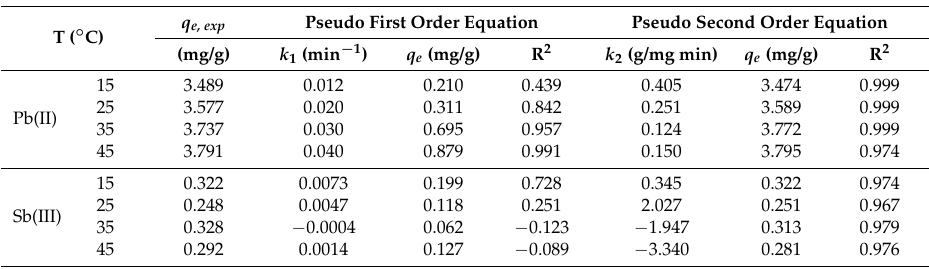
Table 3. Kinetic parameters obtained from pseudo-first-order and pseudo-second-order model for the biosorption of Pb(II) and Sb(III) ions on B. subtilis biomass at different temperatures. q e,exp Pseudo First Order Equation Pseudo Second Order Equation T ( ◦ C) (mg/g) k 1 (min − 1 ) q e (mg/g) R 2 k 2 (g/mg min) q e (mg/g) R 2 15 3.489 0.012 0.210 Pb(II)